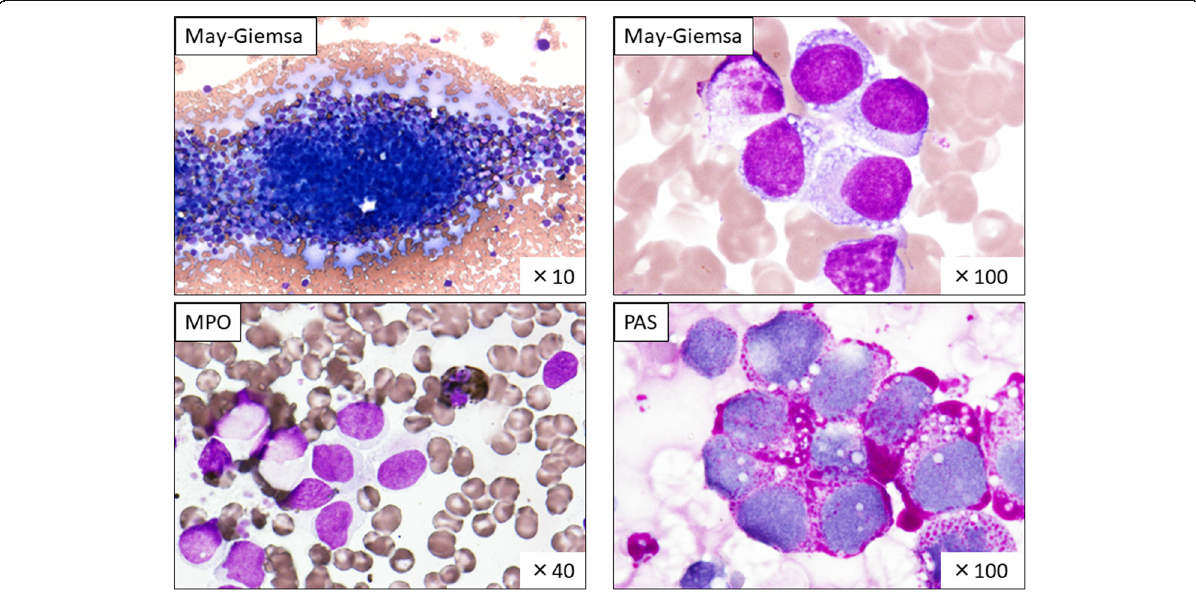
Fig. 2 Bone marrow aspiration cytology The cell count was 1.84 × 10 4 / μ L and the megakaryocyte content was <6 cells/ μ L. The M/E ratio was 7.80/4.88. Myeloblasts accounted for 0.0% and blast-like abnormal cells for 89.0%. May – Giemsa staining indicated a diffuse proliferation of basophilic blastic cells, which harbored gross vacuoles in the cytoplasm. The blastic cells were negative for myeloperoxidase (MPO) and positive for periodic acid – Schiff (PAS)